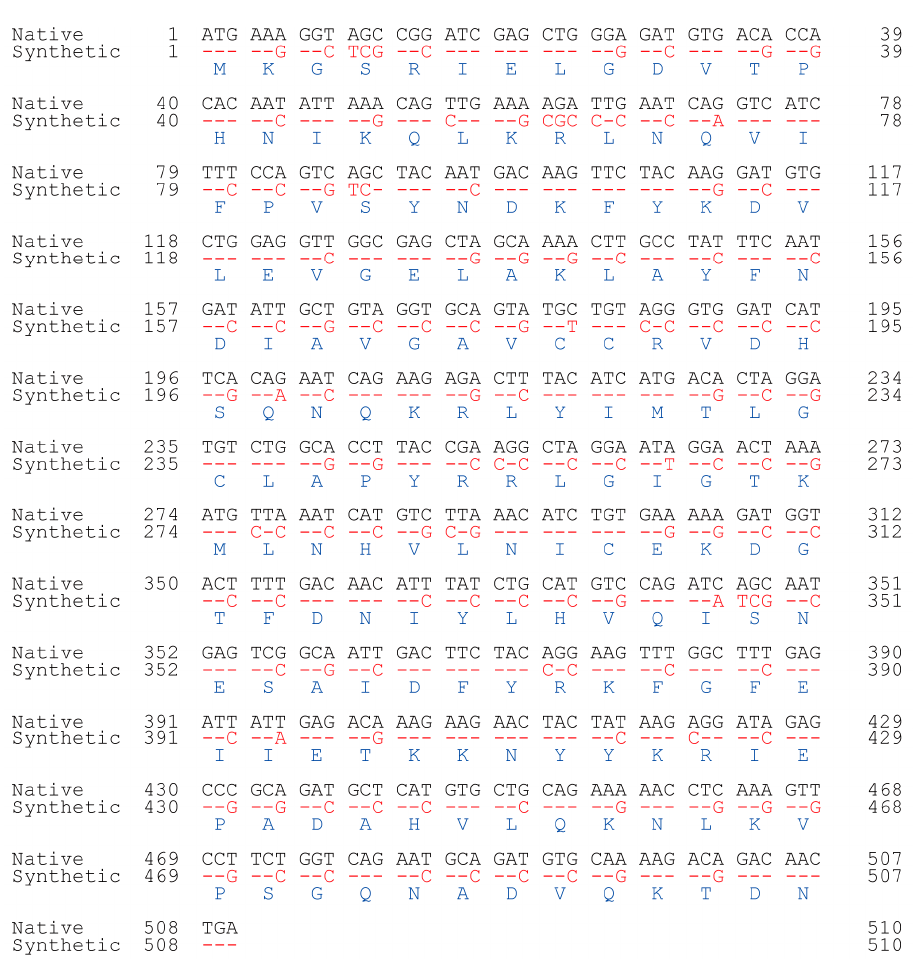
Figure 1. ( A ) Amino acid sequences of Thermoplasma volcanium serotonin N -acetyltransferase (TvSNAT.; NC_002689) and human ( Homo sapiens ) Naa50 (BAB14397). ( B ) Modification of hNaa50 codons. The nucleotide sequence of synthetic hNaa50 was codon-optimized with reference to the rice SNAT2 codon. The N -acetyltransferase domain is underlined. +, similar amino acids.